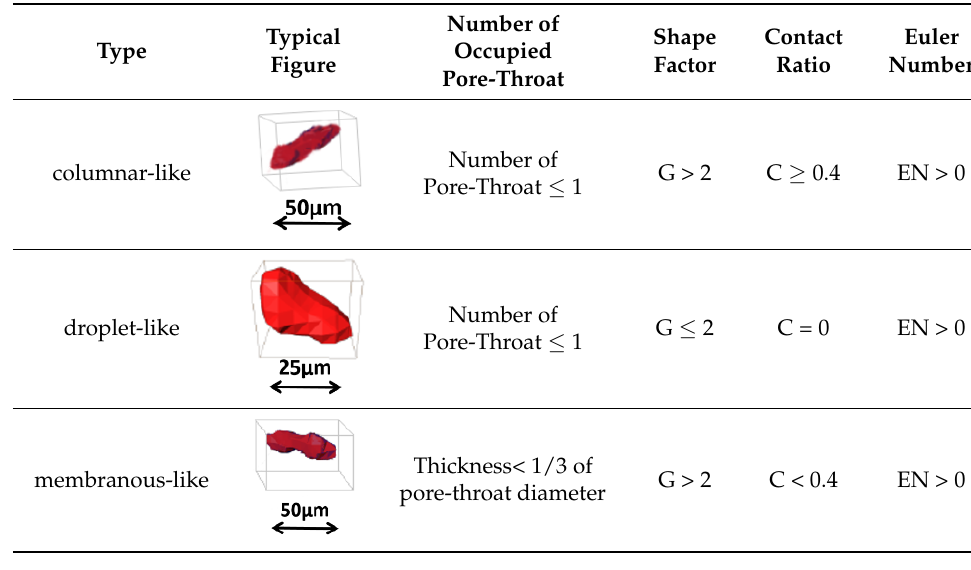
Table 5. emphCont.